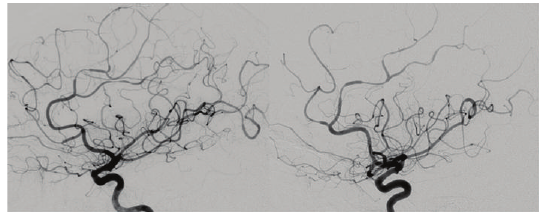
Figure 2: Bilateral internal carotid artery angiography, lateral view, demonstrating severe multifocal vasoconstriction but without any evidence of arteriovenous shunting or aneurysms.